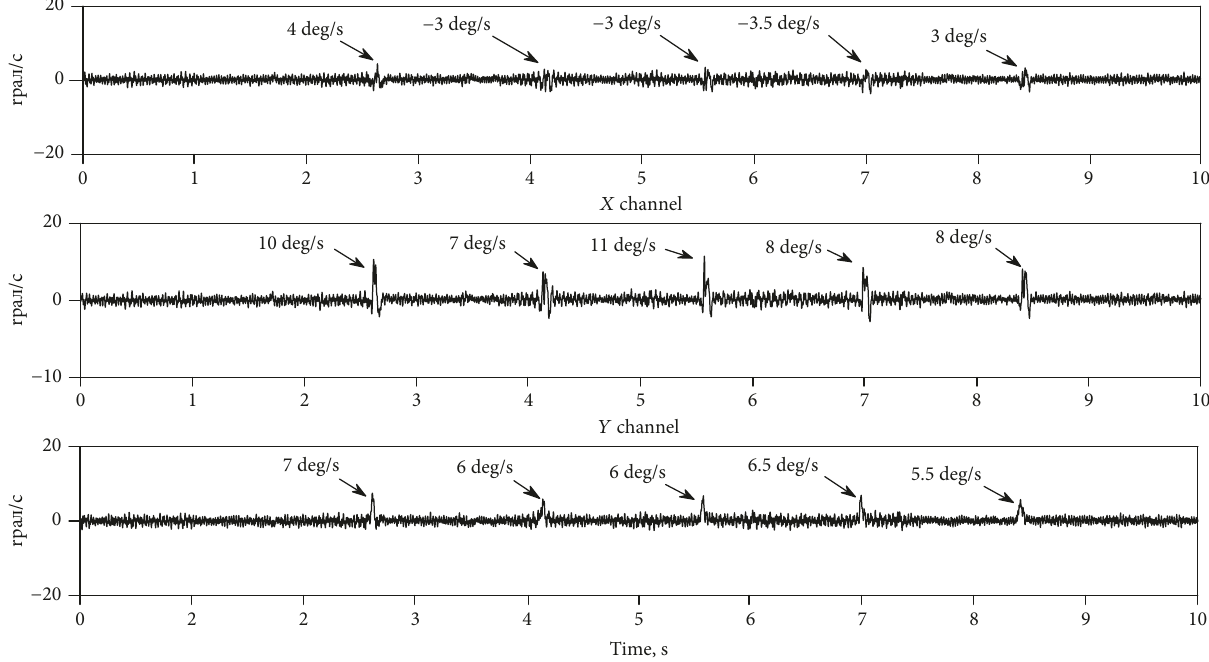
Figure 4: Responses to fi ve shocks of 20 g amplitude and 2ms duration along IA.